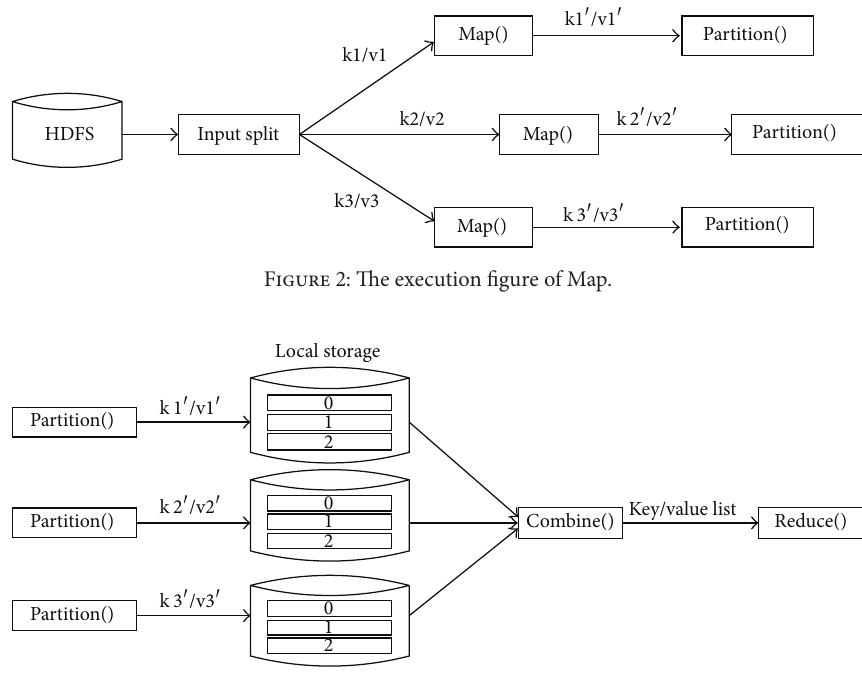
Figure 3: The execution figure of